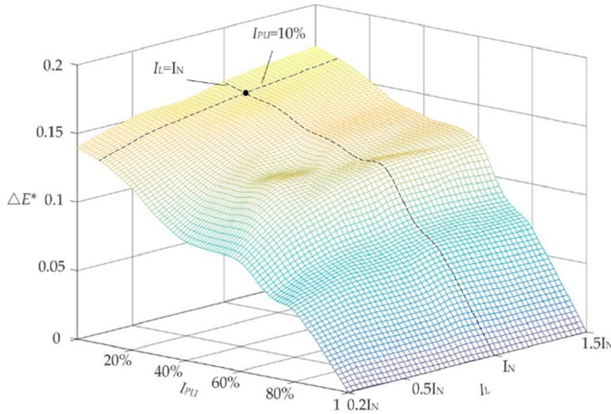
Figure 13. Surface graph of the variety of average loss decrement per unit value with load current and current threshold percentage.